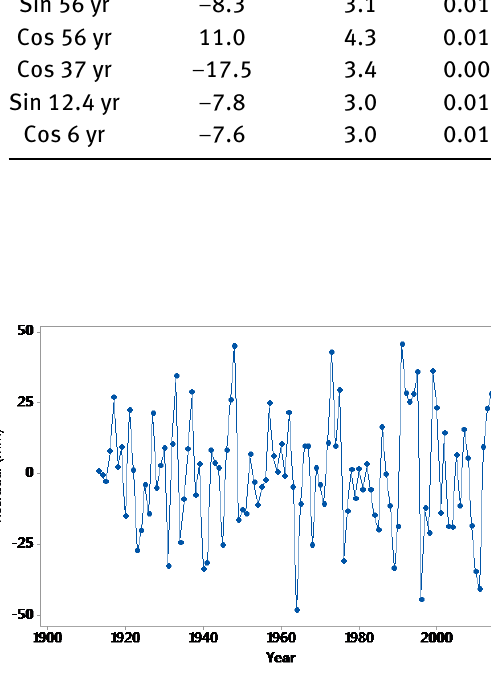
Figure 2: Residuals of the harmonic model solution for the Key West tide gauge data.